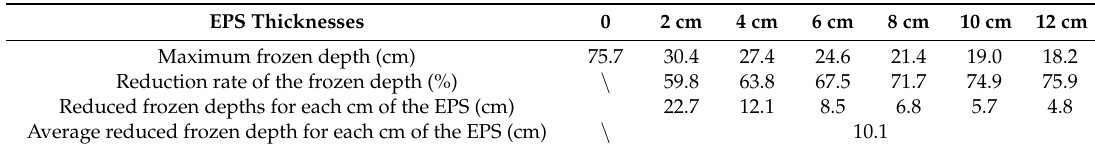
Table 5. Reduction rates of the frozen depths under the different EPS thicknesses and the reduced frozen depths for each cm of the EPS.